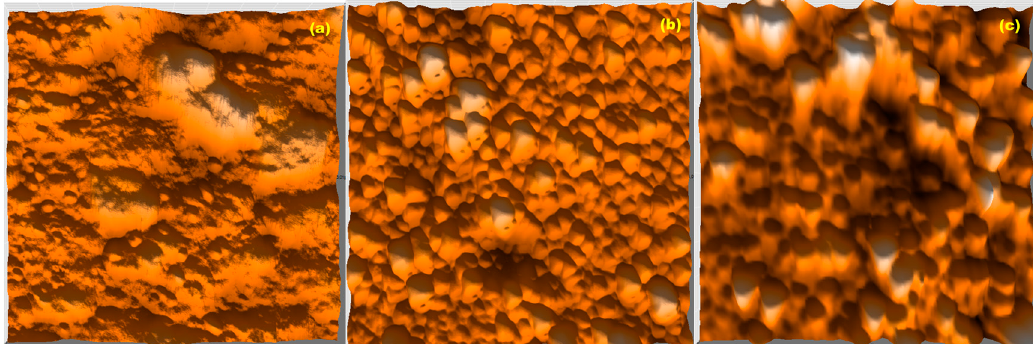
Figure 4. AFM images (3×3 μ m 2 ) of ( a ) bare ITO electrode; ( b ) After deposition of ZnO nanoparticles; ( c ) after further ZnO nanorods